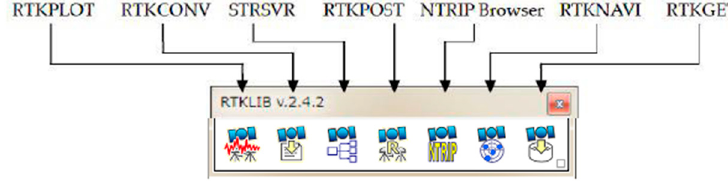
Figure 2. Screenshot of graphical user interface of the RTKLAUNCH module.